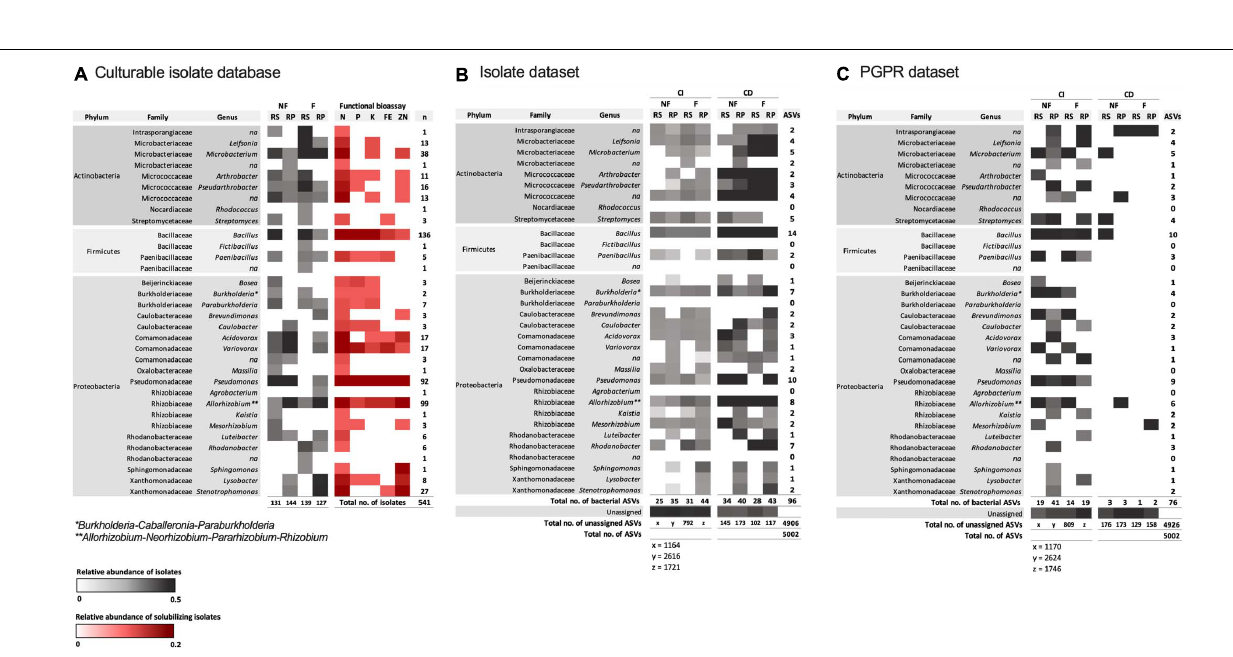
Frontiers in Microbiology |